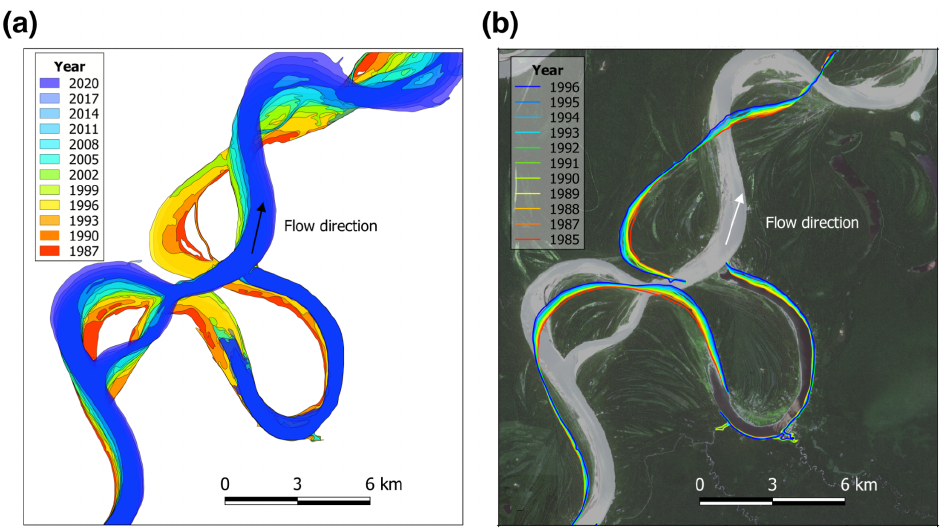
Figure 4. ( a ) Planform migration of the DS bend (see Figure 1 for location) from 1987 to 2020. ( b ) The migration of the outer bank from 1985 to 1996 when the neck cutoff